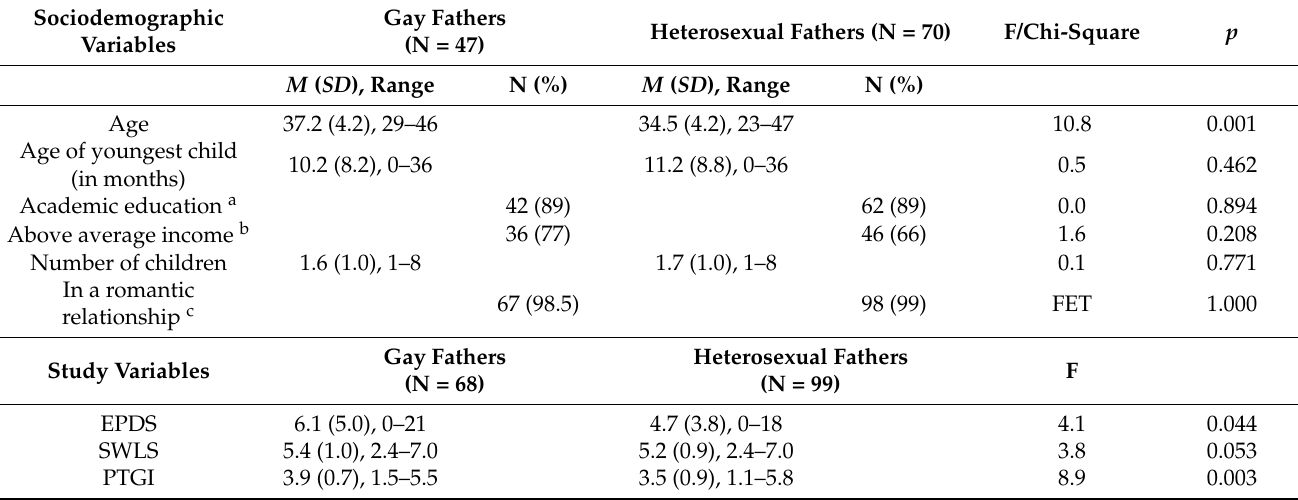
Table 1. Group comparisons in demographic variables and in the main study